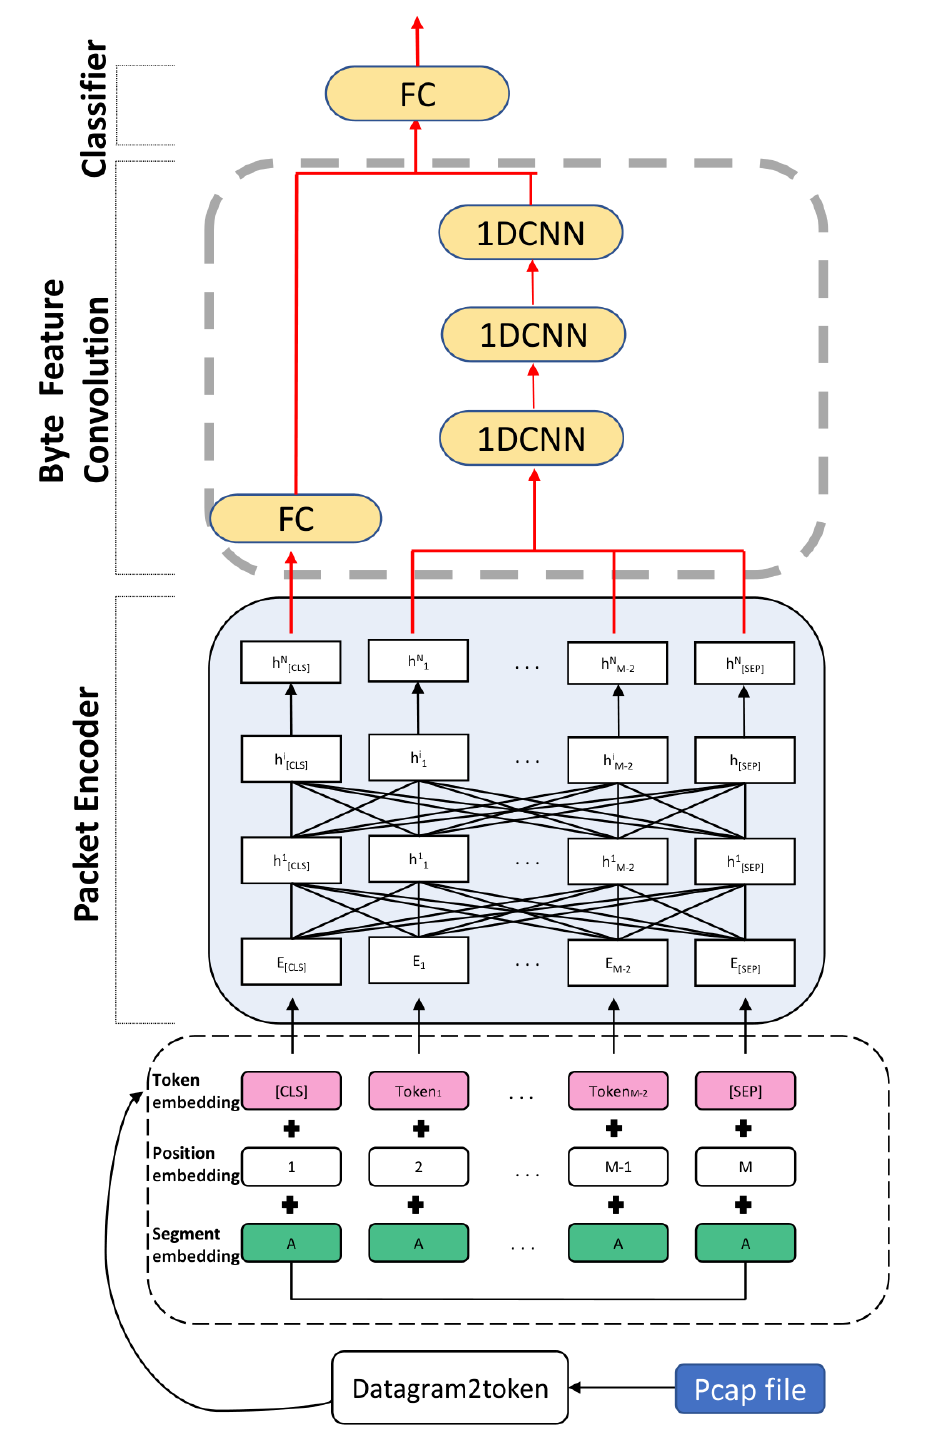
Figure 1. Byte feature convolution model network (BFCN)